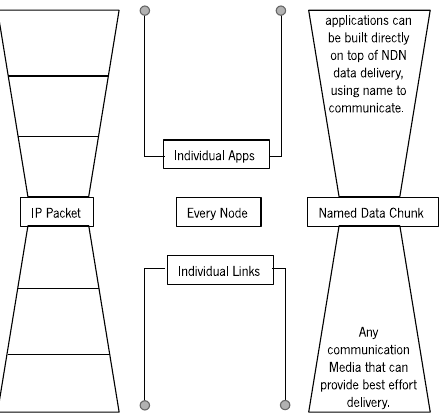
Figure 1. IP and NDN hourglass architectures (Adapted from [14]).